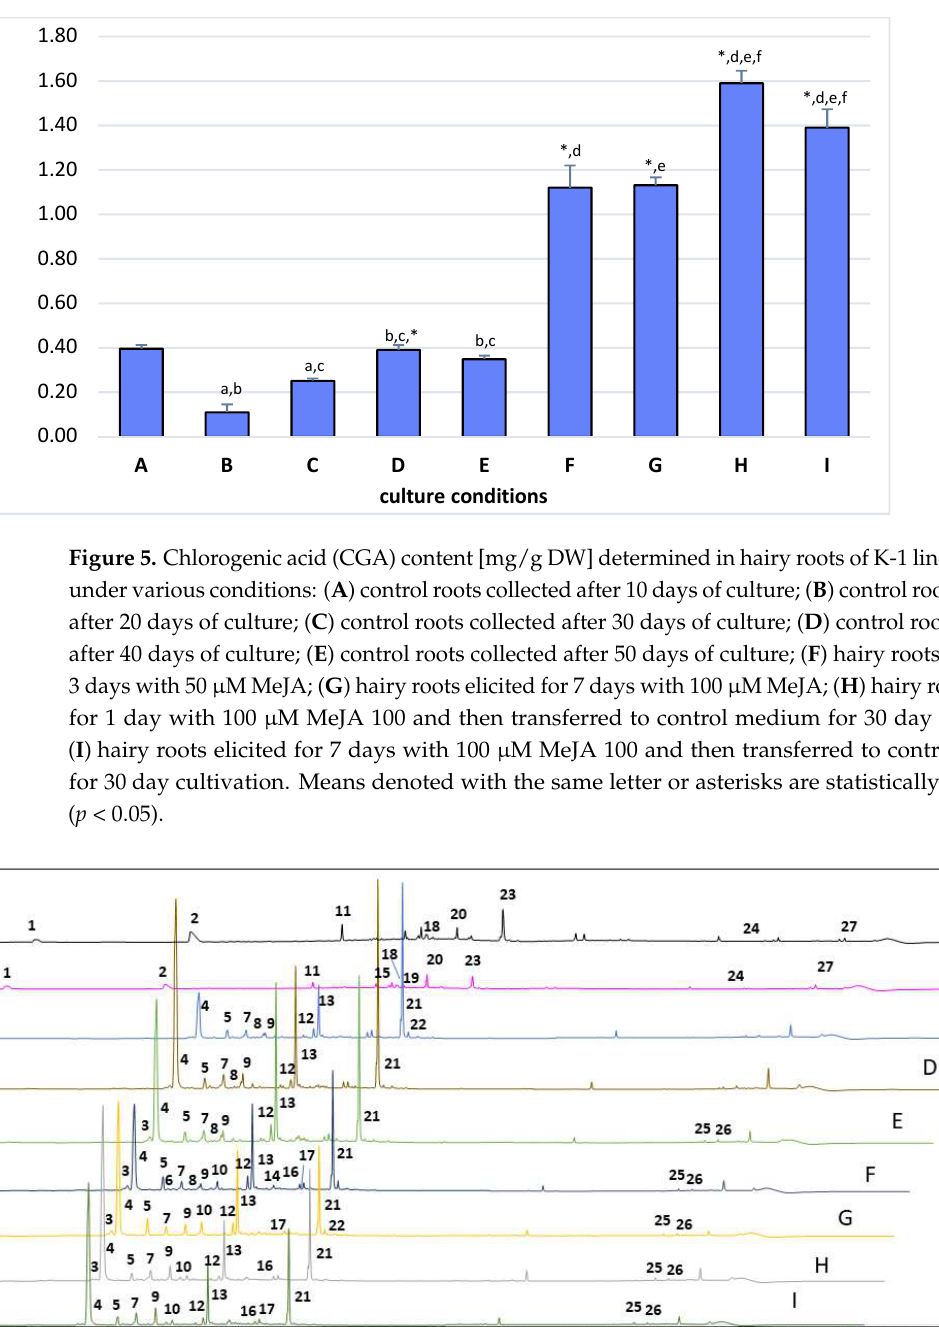
Table 2. HPLC-PDA-ESI-MS analysis of hairy root extracts based on standard compounds used in present study.